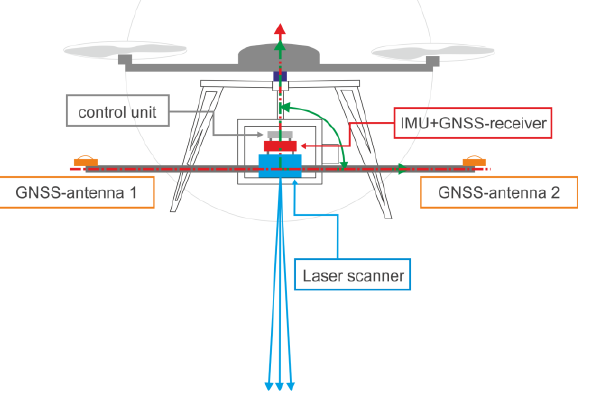
Figure 7. General concept of the flight and sensor platform The position and trajectory of the sensor platform is determined by a GNSS receiver with the corresponding antenna. To avoid multipath and interferences, we placed a second GNSS antenna eccentrically on a carbon bar (each in the end of the bar) which is controlled by a dual GNSS receiver with the corresponding input for two antennas. This configuration is supported on the ground by a GNSS base station. An inertial measurement unit is firmly attached to the sensor platform. The advantage of this configuration is that the trajectory can better be evaluated. The measured base length is compared with the calibrated distance between the GNSS antennas to sort out possible outliers (see fig. 8).